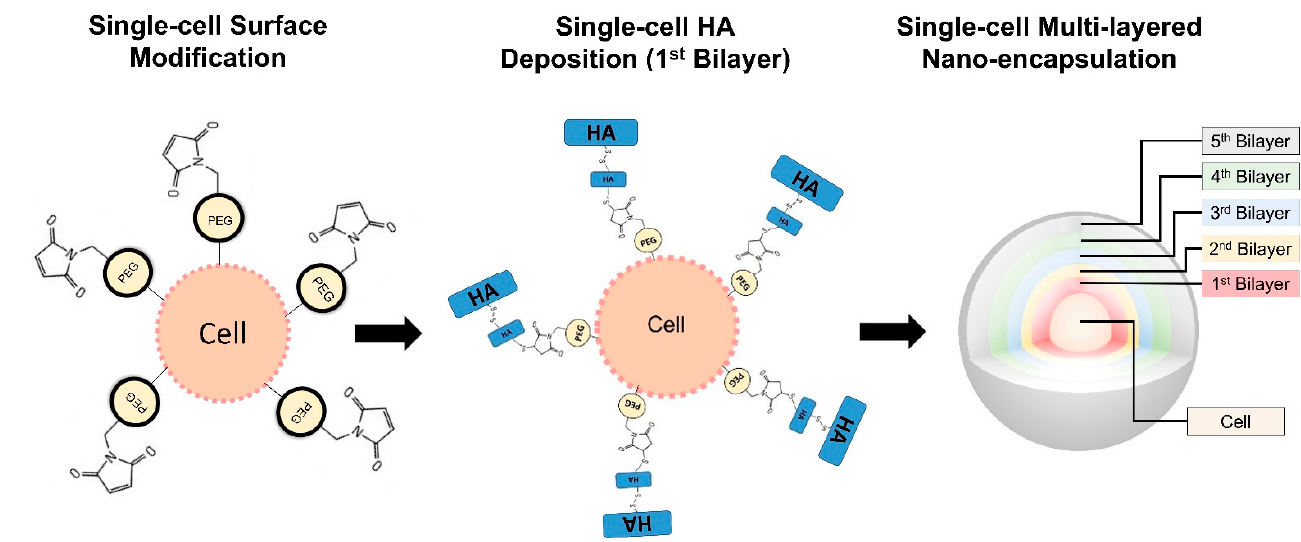
Figure 1. Schematic representation of free-floating single cell encapsulation. Surface modification using Mal-PEG-DPPE and deposition of multiple layers of HA derivates.